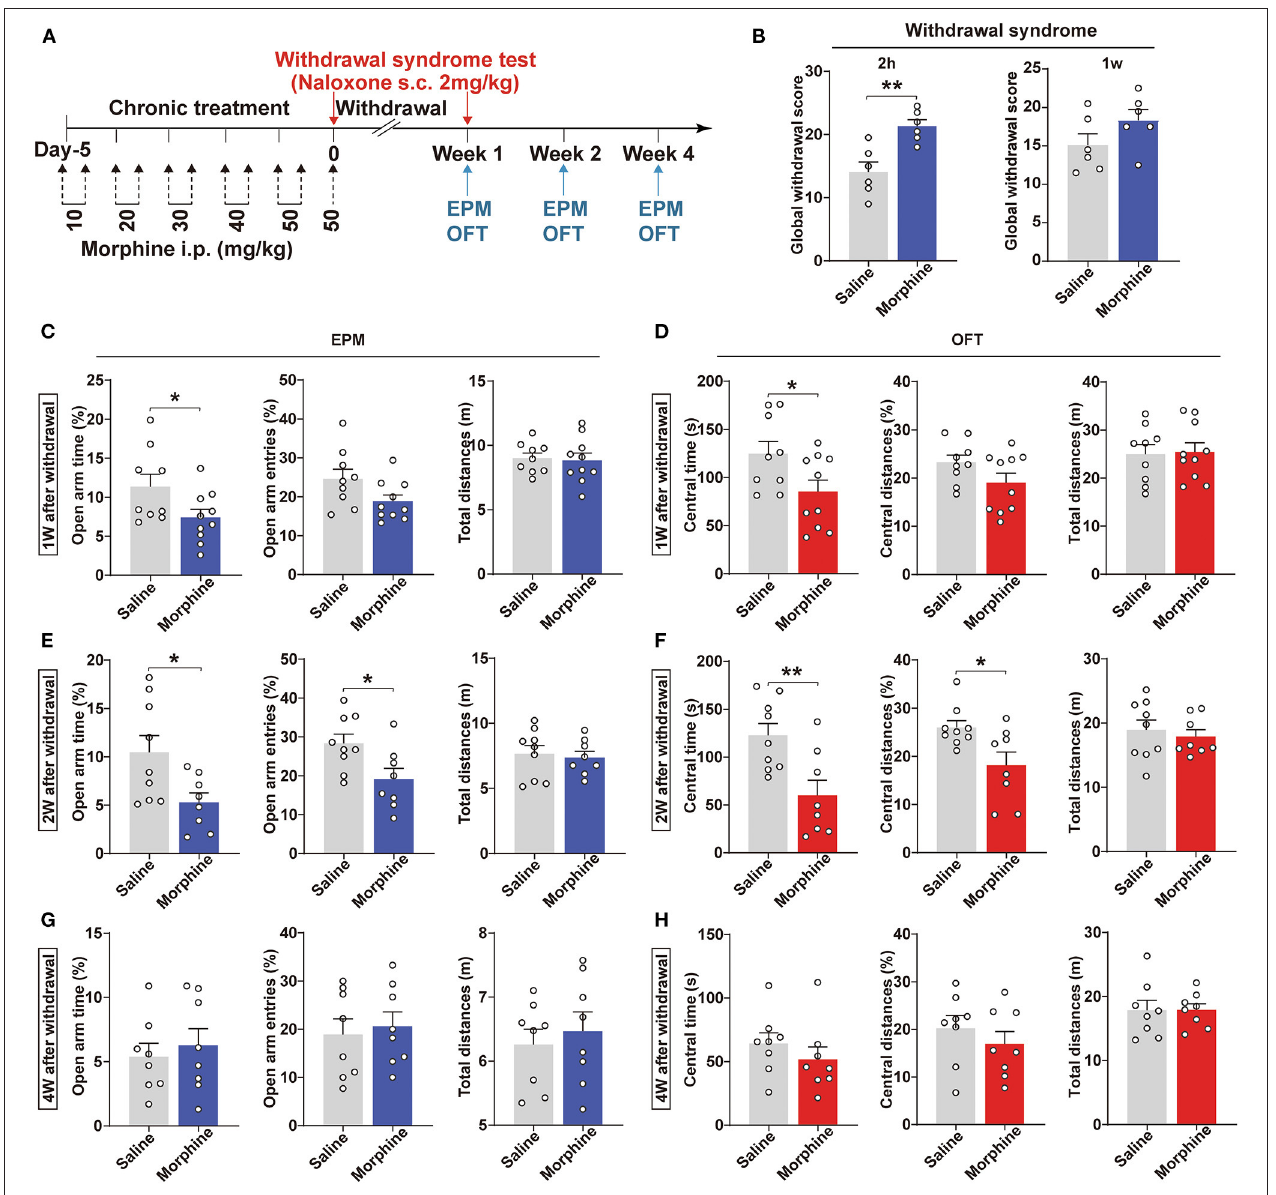
FIGURE 1 | Morphine-withdrawn mice show anxiety-like behaviors. (A) Schematics of the experiment. (B) The global withdrawal score of morphine was higher than saline after withdrawal 2h from morphine; 2 mg/kg of naloxone was injected subcutaneously (s.c.) into morphine and saline mice. Anxiety-like behavioral tests using the EPM and OFT at 1 week (C,D) , 2 weeks (E,F) , and 4 weeks (G,H) of withdrawal. Data were expressed as the mean ± SEM. (B) n = 6/group, (C–F) n = 8–10/group * P < 0.05, ** P < 0.01, compared with saline group.